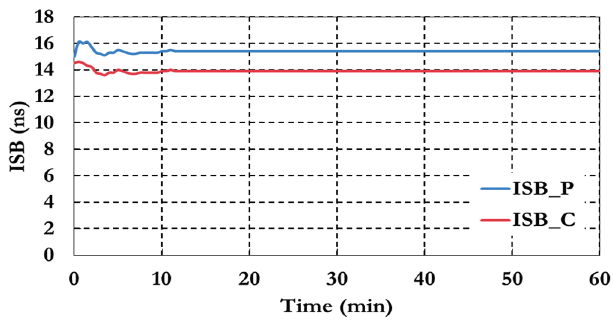
Figure 15. Inter-system bias of the semi-decoupled clock GPS/Galileo PPP model.